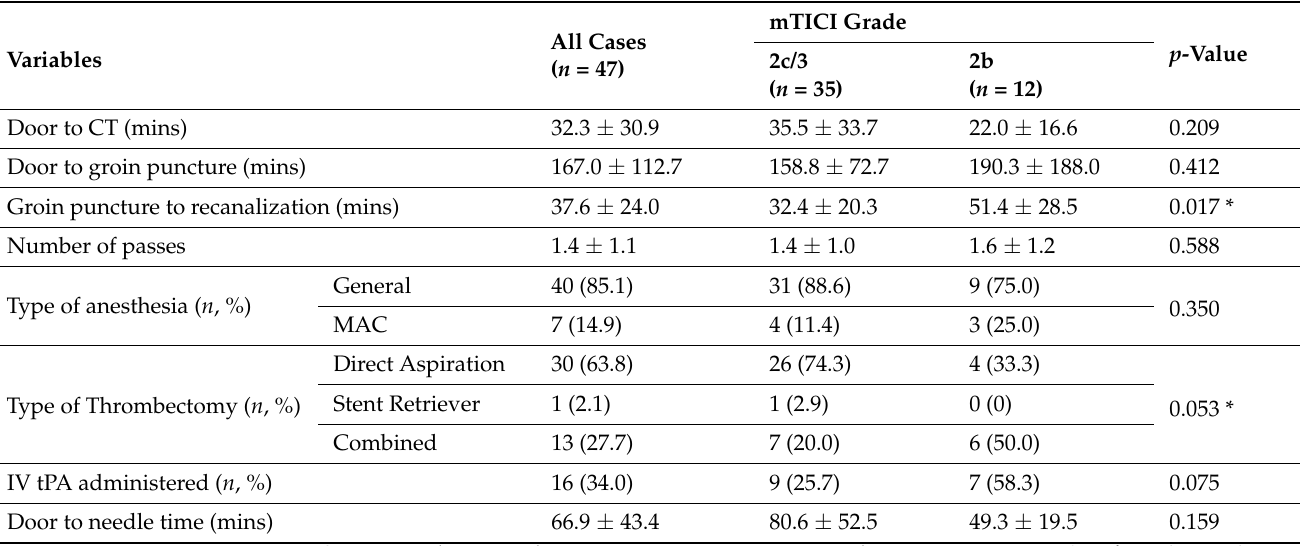
Table 2. Comparison of intervention and time parameter data between the mTICI 2b and mTICI 2c/3 cohorts.